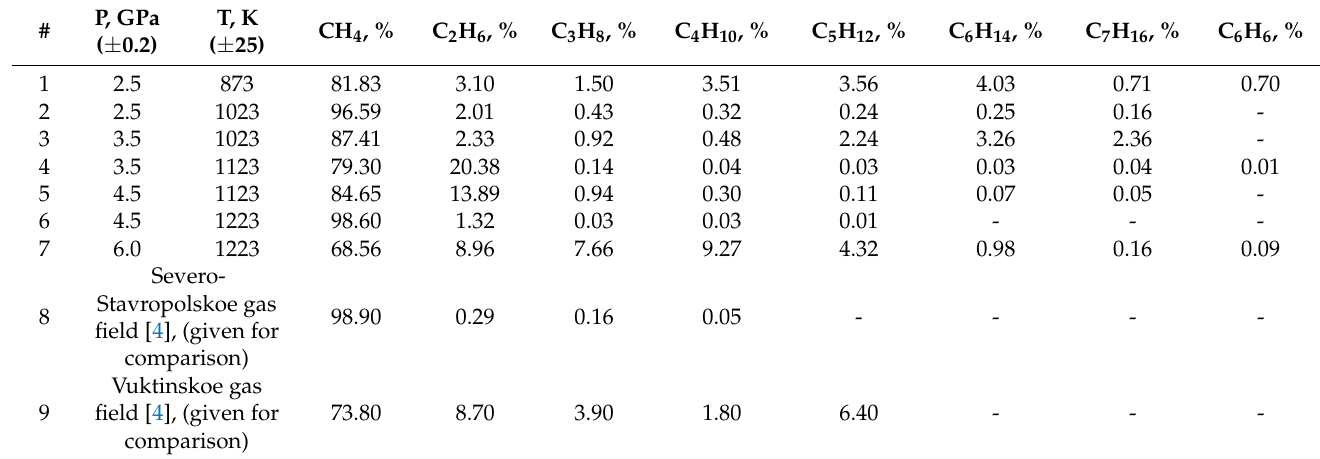
Table 1. Composition and Volume of the Product Systems Formed from Fe 3 C and H 2 O According to the Thermobaric Conditions of the